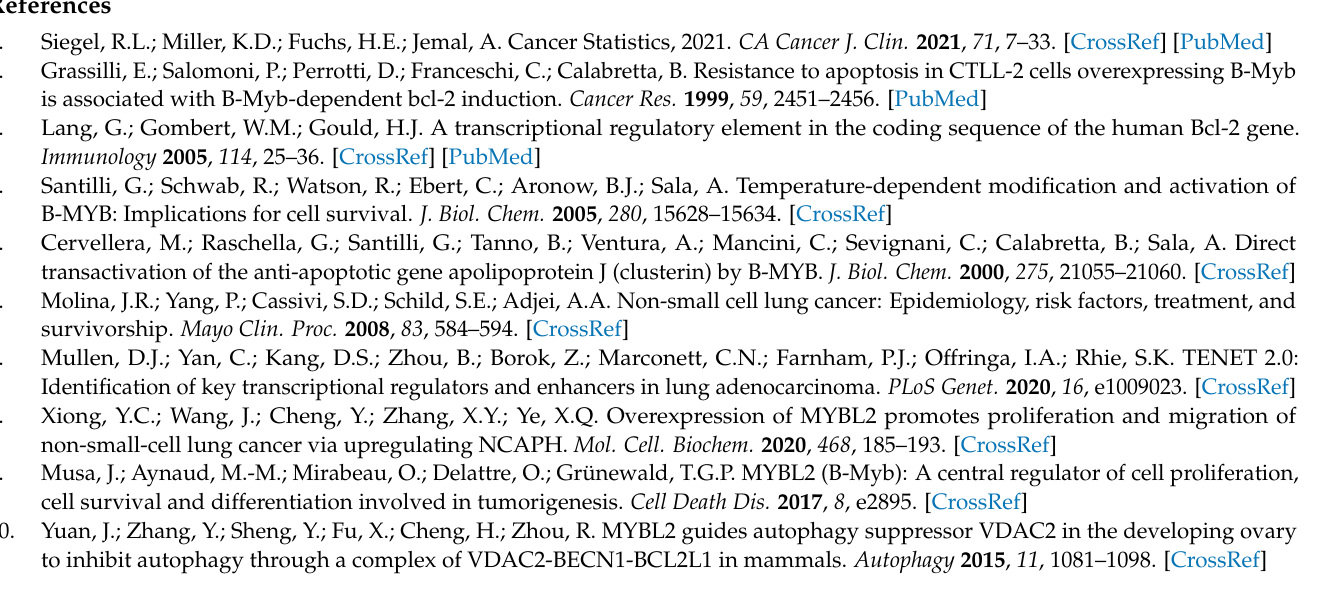
Table S1: Datasets used in this study. Supplementary Table S2: Binding sites of MYBL2 and FOXM1. Supplementary Table S3: Motifs enriched in MYBL2, FOXM1, Common, MYBL2-unique, and FOXM1- unique binding sites. Supplementary Table S4: A list of differentially expressed genes for siMYBL2 vs. siControl, siFOXM1 vs. siControl, siMYBL2 and siFOXM1 vs. siControl, and FDI-6 vs. DMSO comparisons. Supplementary Table S5: Signaling pathway analysis results for genes regulated by MYBL2 and FOXM1 and FDI-6 affected genes. Supplementary Table S6: Primer sequences used for